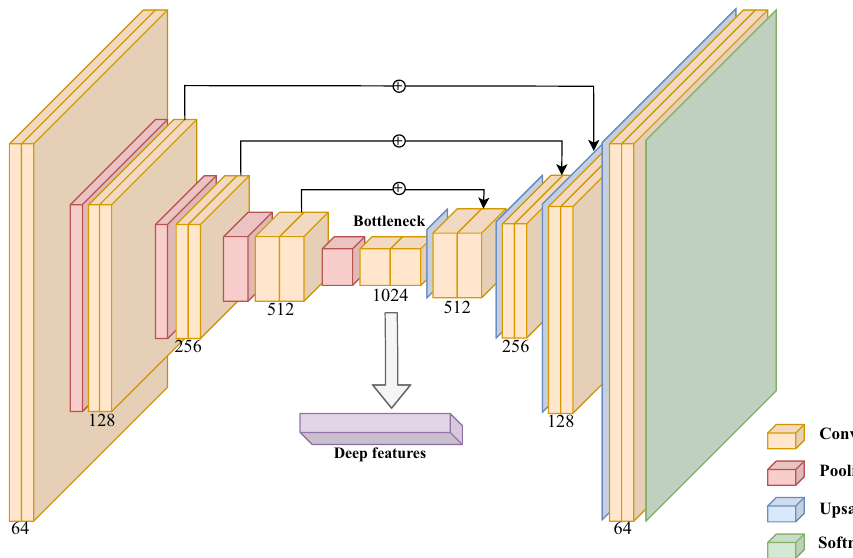
Figure 2. Representation of the deep feature extraction procedure from the segmentation models. These features are extracted from the bottleneck of the encoder-decoder model following three different